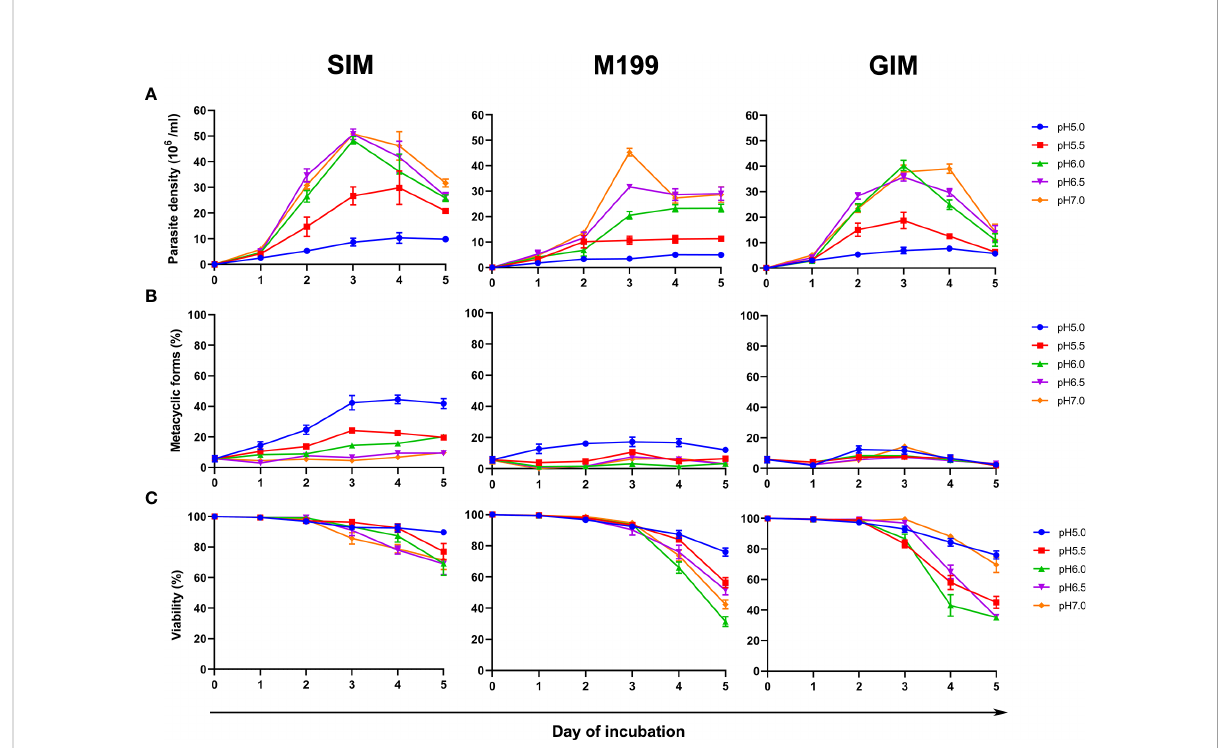
FIGURE 1 Comparison of density, metacyclogenesis and viability under various culture conditions. Promastigote cultures were initiated at 1 × 10 6 cells/ml. (A) Parasite density, (B) Percentage of metacyclic promastigotes, and (C) Percentage viability of L. orientalis promastigotes cultured in SIM, M199, and GIM at different pH values, 5.0, 5.5, 6.0, 6.5, and 7.0, in each case supplemented with 20% (v/v) FBS. Results are expressed as mean ± standard deviation and are based on three independent